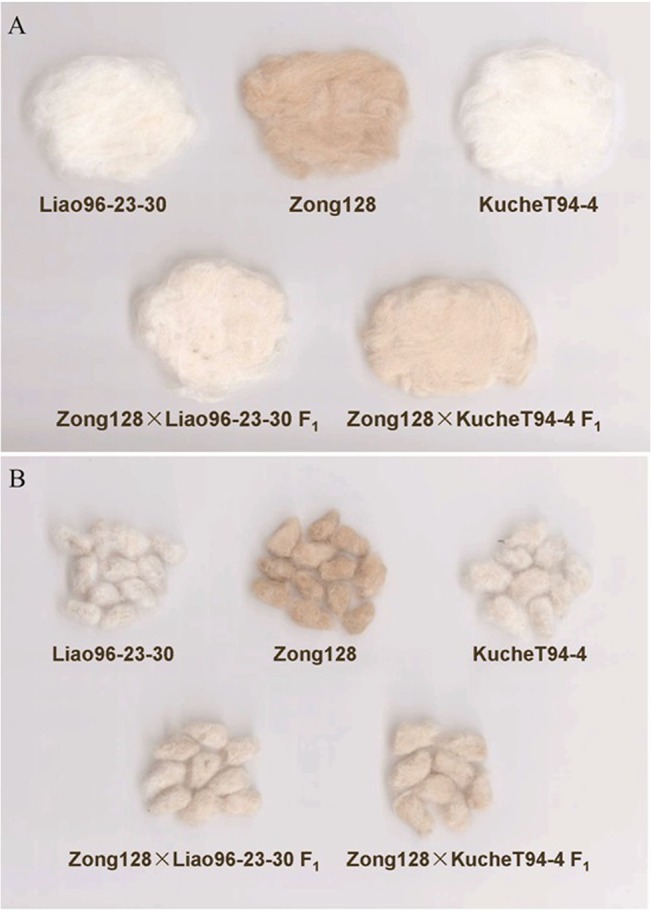
A. the lint colored of parents and F1 generation; B: fuzz color of parents and F1 generation.